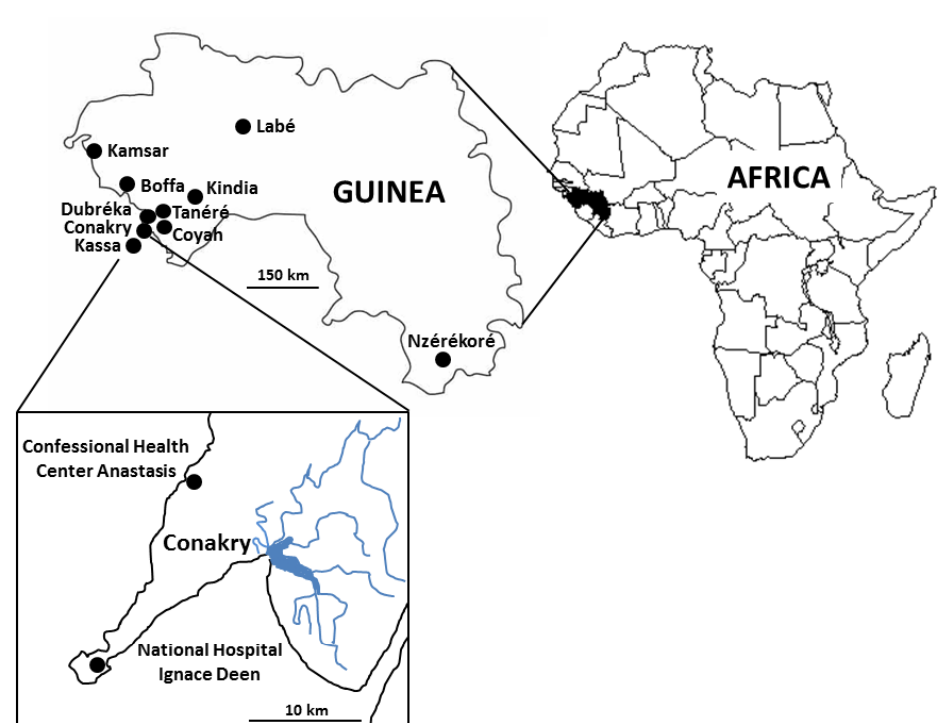
Figure 1. Map of Guinea showing the Conakry area where the study was conducted and the residence of the subjects enrolled in this study; the black box frames the two sites of participating hospitals: Confessional Health Center Anastasis and National Hospital Ignace Deen of Conakry. Briefly, a cohort of 500 patients followed up at the two hospitals for different pa- thologies, with/without gastrointestinal symptoms, were enrolled (Table 1). A total of 250 stool samples (1 sample per patient) were collected at each participating center during routine clinical procedures. The majority of the subjects participating in this study (81.0%, 405/500) lived in Conakry while the other participants came from towns in the suburbs of Conakry, such as Coyah (2 subjects), Tanéré (1), Kassa (1) and Dubréka (12) or from towns farther away, such as Kindia (74), Boffa (1), Kamsar (2), Labé (1) and Nzérékoré (1). The significant number of subjects followed in CHCA and living in Kindia could easily be explained by the proximity of this hospital to this city. Table 1. Distribution of participants according to their place of residence and the attendance to the two selected hospitals.